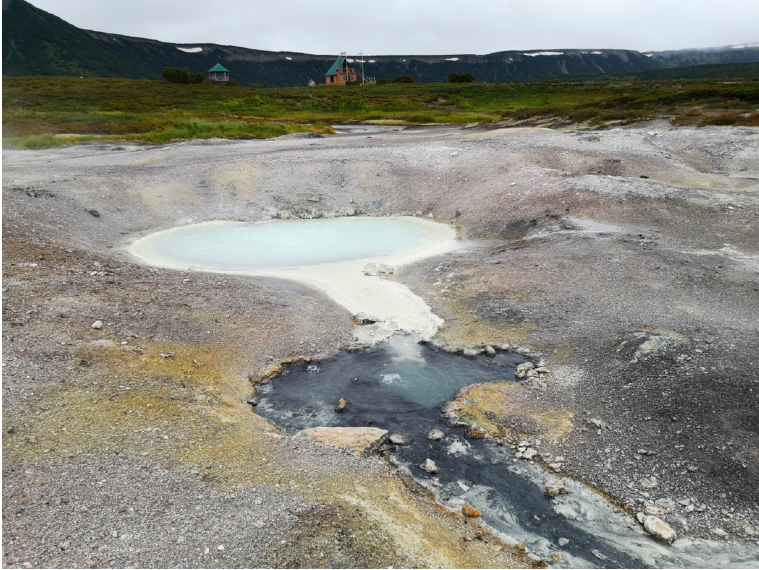
Figure A11. Shaman-2 CO 2 -hot spring located adjacent to the Shaman geyser (next candidate to be a geyser in the Uzon caldera). Photo by A. Kiryukhin, 25 August 2019.